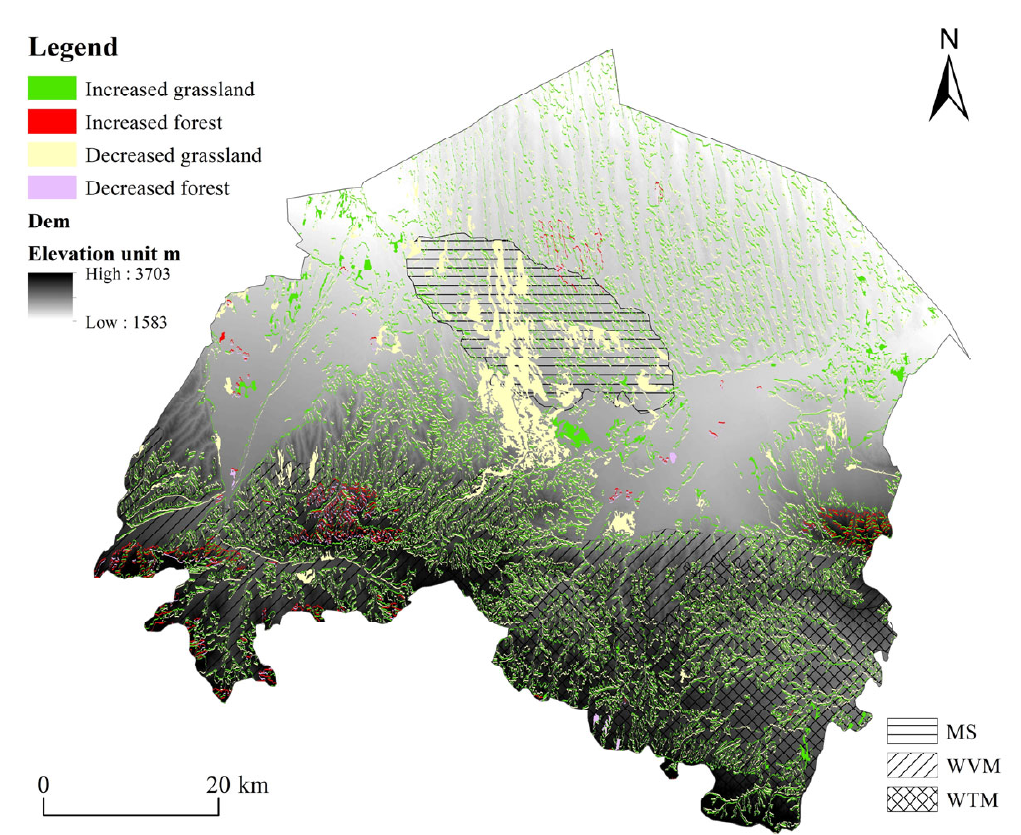
Figure 9. Distribution of forest and grassland changes.